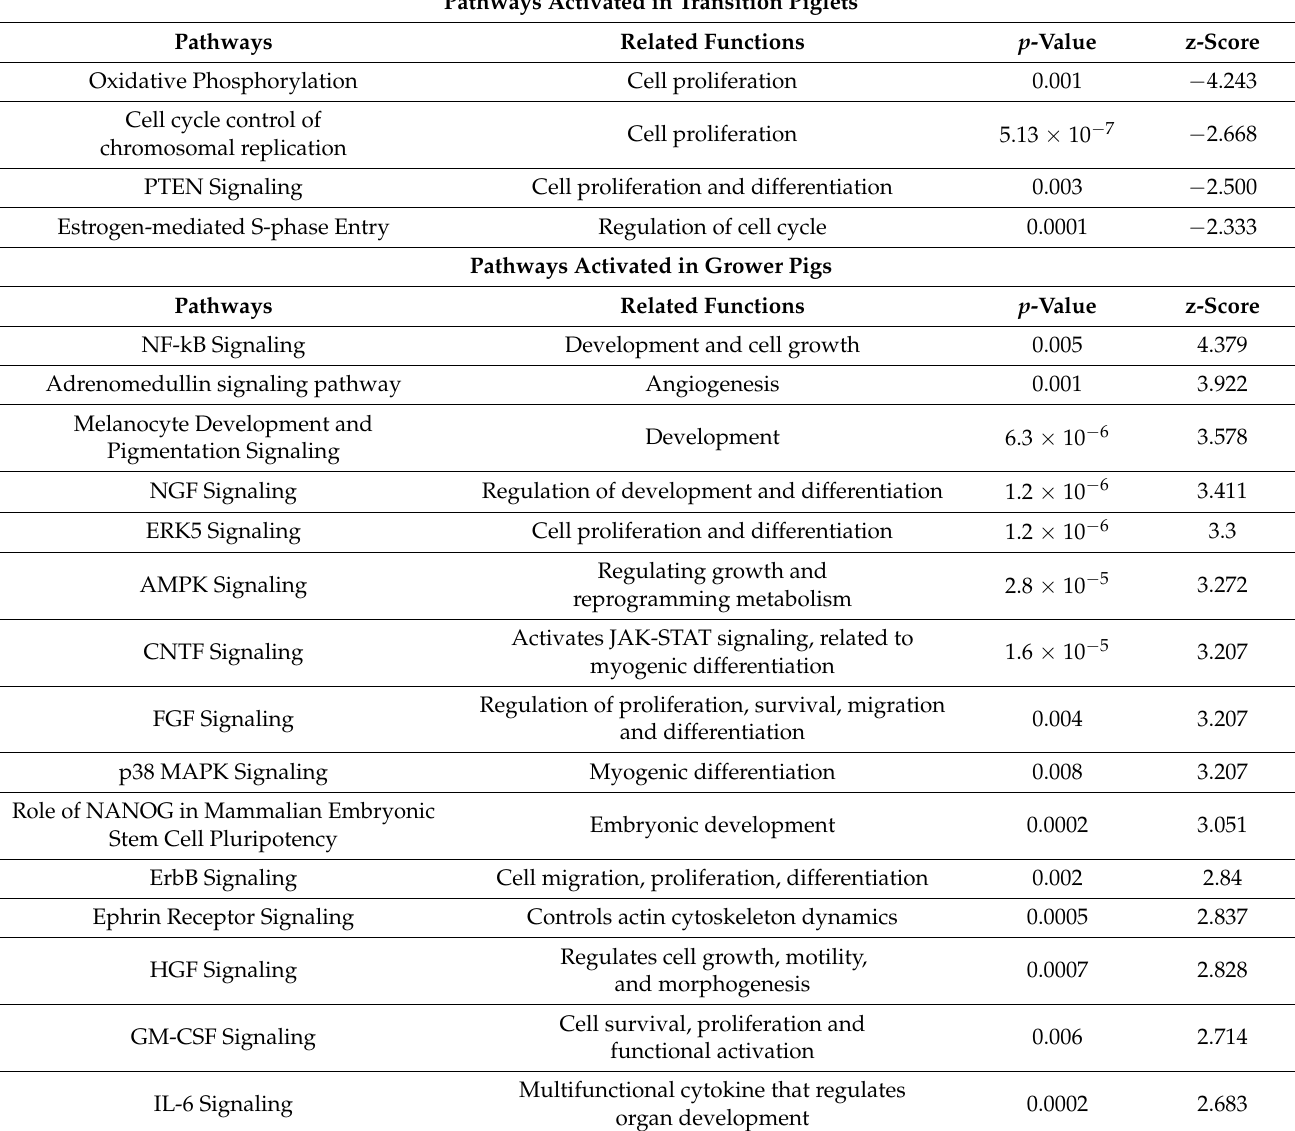
Most relevant canonical pathways activated in transition piglets and growers, related to cell growth and